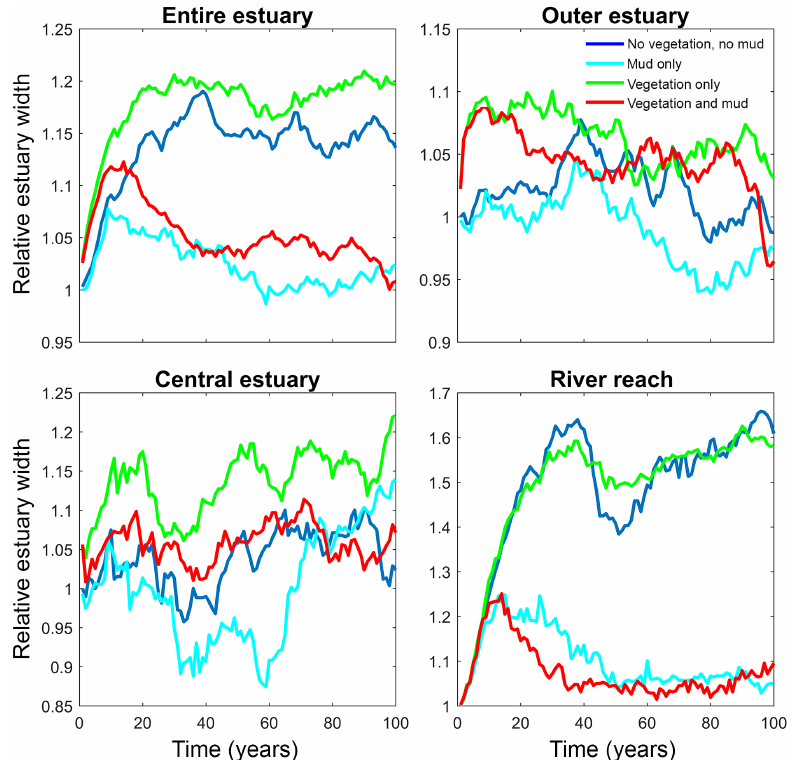
Figure 6. Estuary width over time for of the entire system and for zones along the estuary. Width is normalised by average initial width. See Fig. 2 for locations of zones.